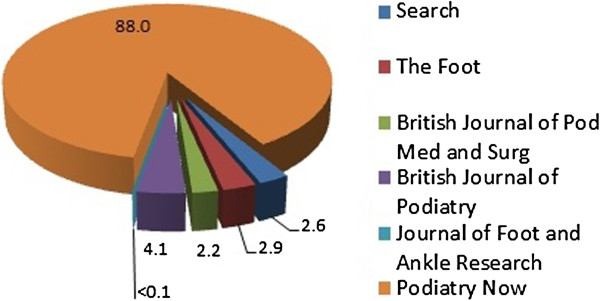
Total journal share (%).